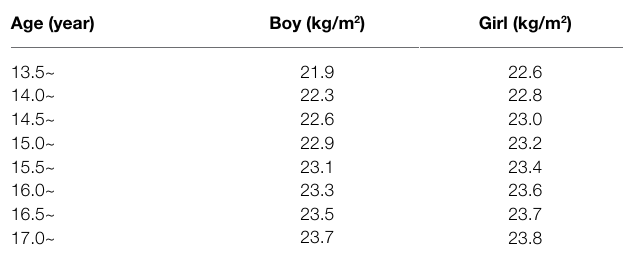
TABLE 1 | BMI threshold for overweight